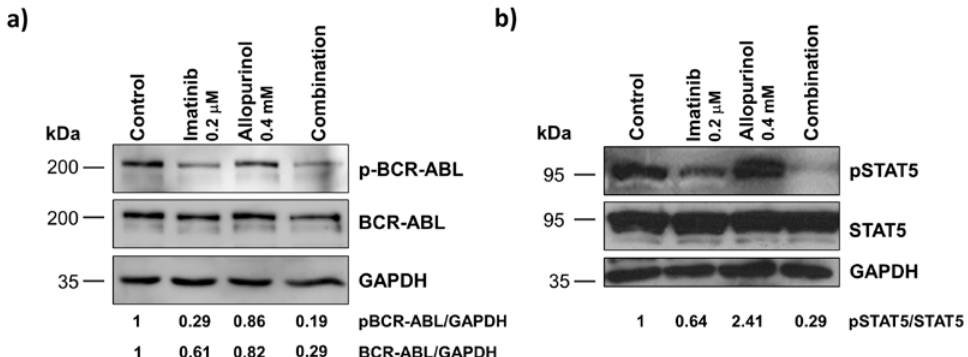
Figure 8. The combination of imatinib and allopurinol reduces the levels of phospho-BCR-ABL, BCR-ABL, and phospho-STAT5. K562 cells were treated with 0.2 μM imatinib, 0.4 mM allopurinol, or their combination for 6 h. The level of the phosphorylated-activated forms of BCR-ABL and STAT5 was analyzed by immunoblotting. The same membranes were stripped and reprobed to detect the total levels of these proteins. GAPDH was used as a loading control. Representative experiments are shown. ( a ) pBCR-ABL/BCR-ABL levels ( n = 6). ( b ) pSTAT5/STAT5 ( n = 4) levels.